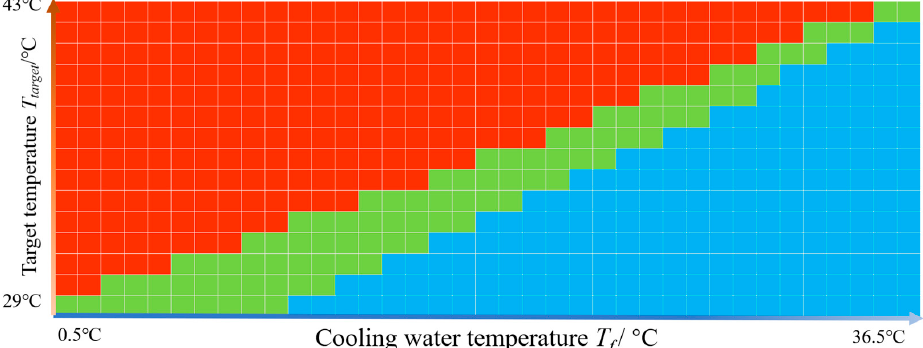
Figure 8. The combined conditions that were feasible for the control of conformal heating. Feasible cases are shown in green, in which the temperature close to the inner surface was below 50 °C, while the temperatures in the deeper sites were above 50 °C. The excessive heating cases are shown in red, where the temperature close to the tissue's inner surface was above 50 °C. The insufficient cases are shown in blue, where the temperatures in all regions were below 50 °C. The target temperature ( T target ) ranged